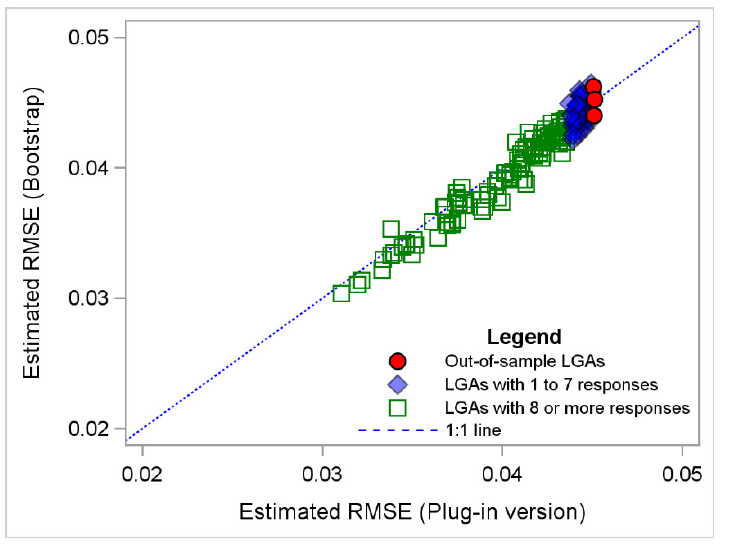
Figure 3. Bootstrap versus plug-in RMSEs for LGA-level EBLUP model-based estimates of proportion of smoking in males, 2006, using linear mixed model. Model included age group only.